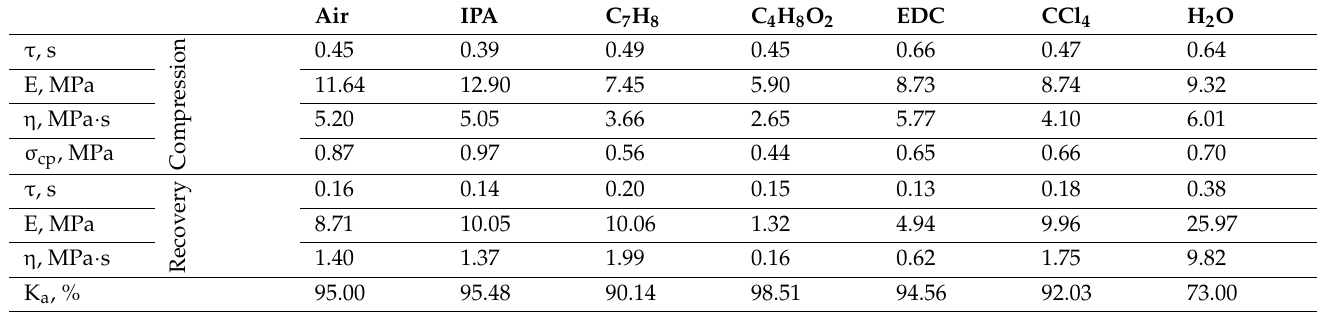
Table 2. Physical properties of the ‘composite–liquid’ system for the Saphira 1000 (EPDM) blanket.